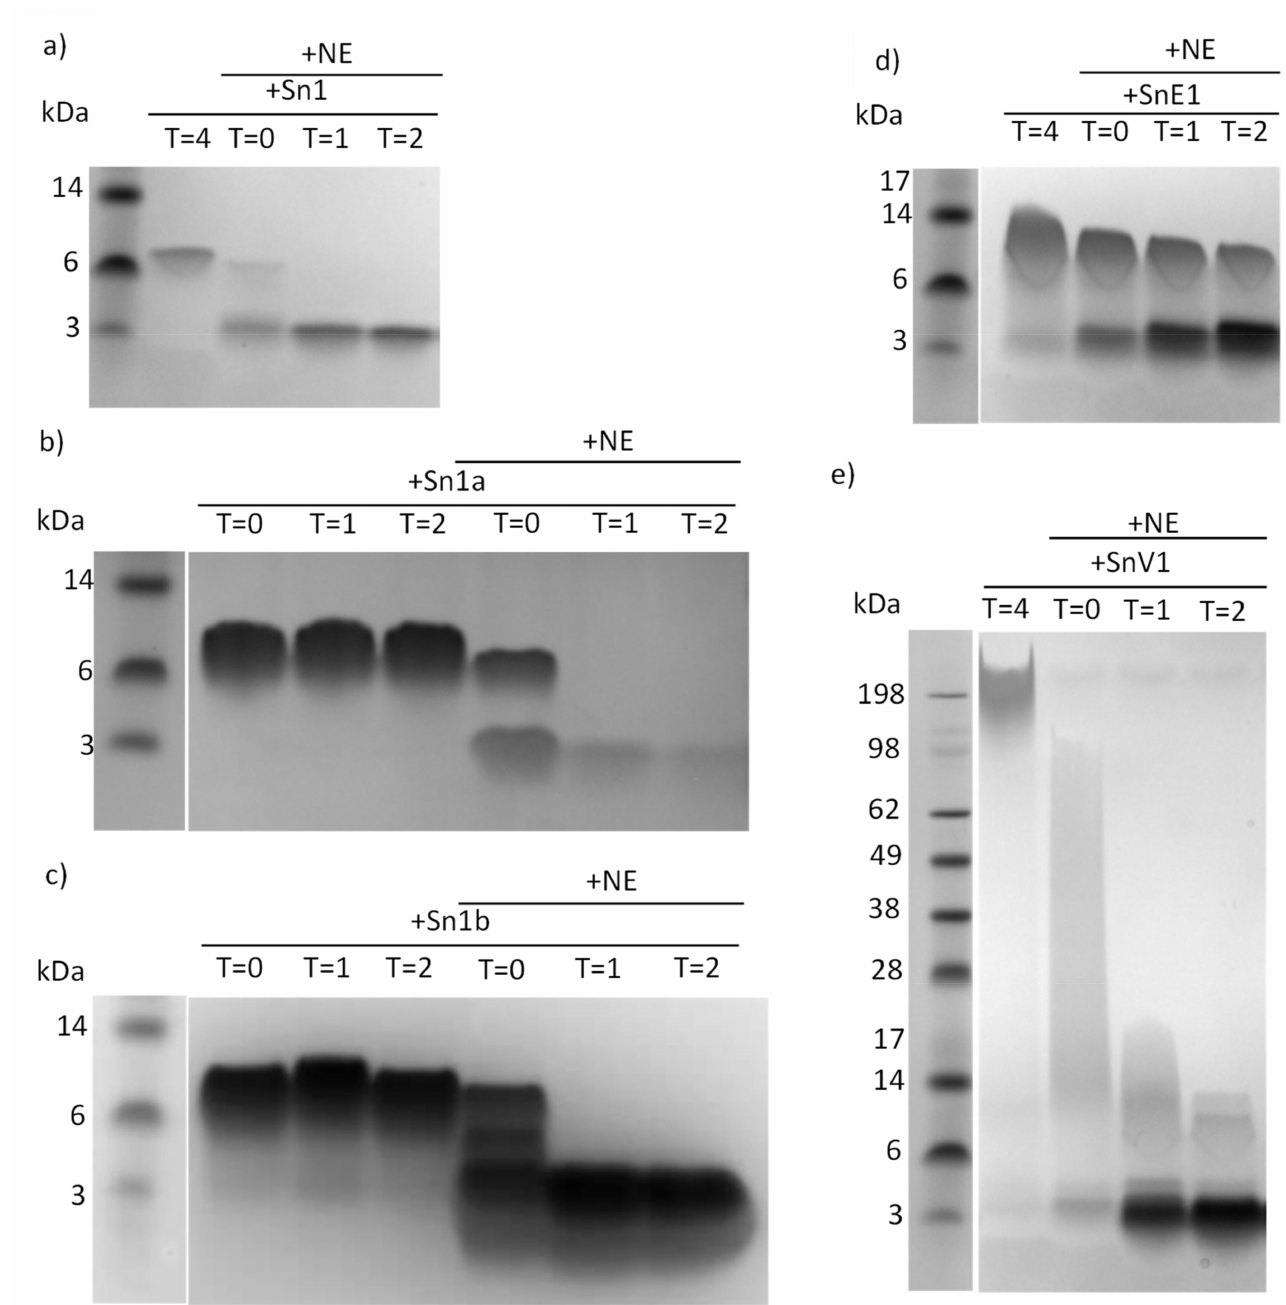
Figure 3. SDS-PAGE gels of peptides incubated with NE. An aliquot of 500 µ g/mL of ( a ) Sn1, ( b ) Sn1a, ( c ) Sn1b, ( d ) SnE1 or ( e ) SnV1 was incubated with 500 nM of neutrophil elastase for 0–4 h. Samples were electrophoresed and stained with Coomassie